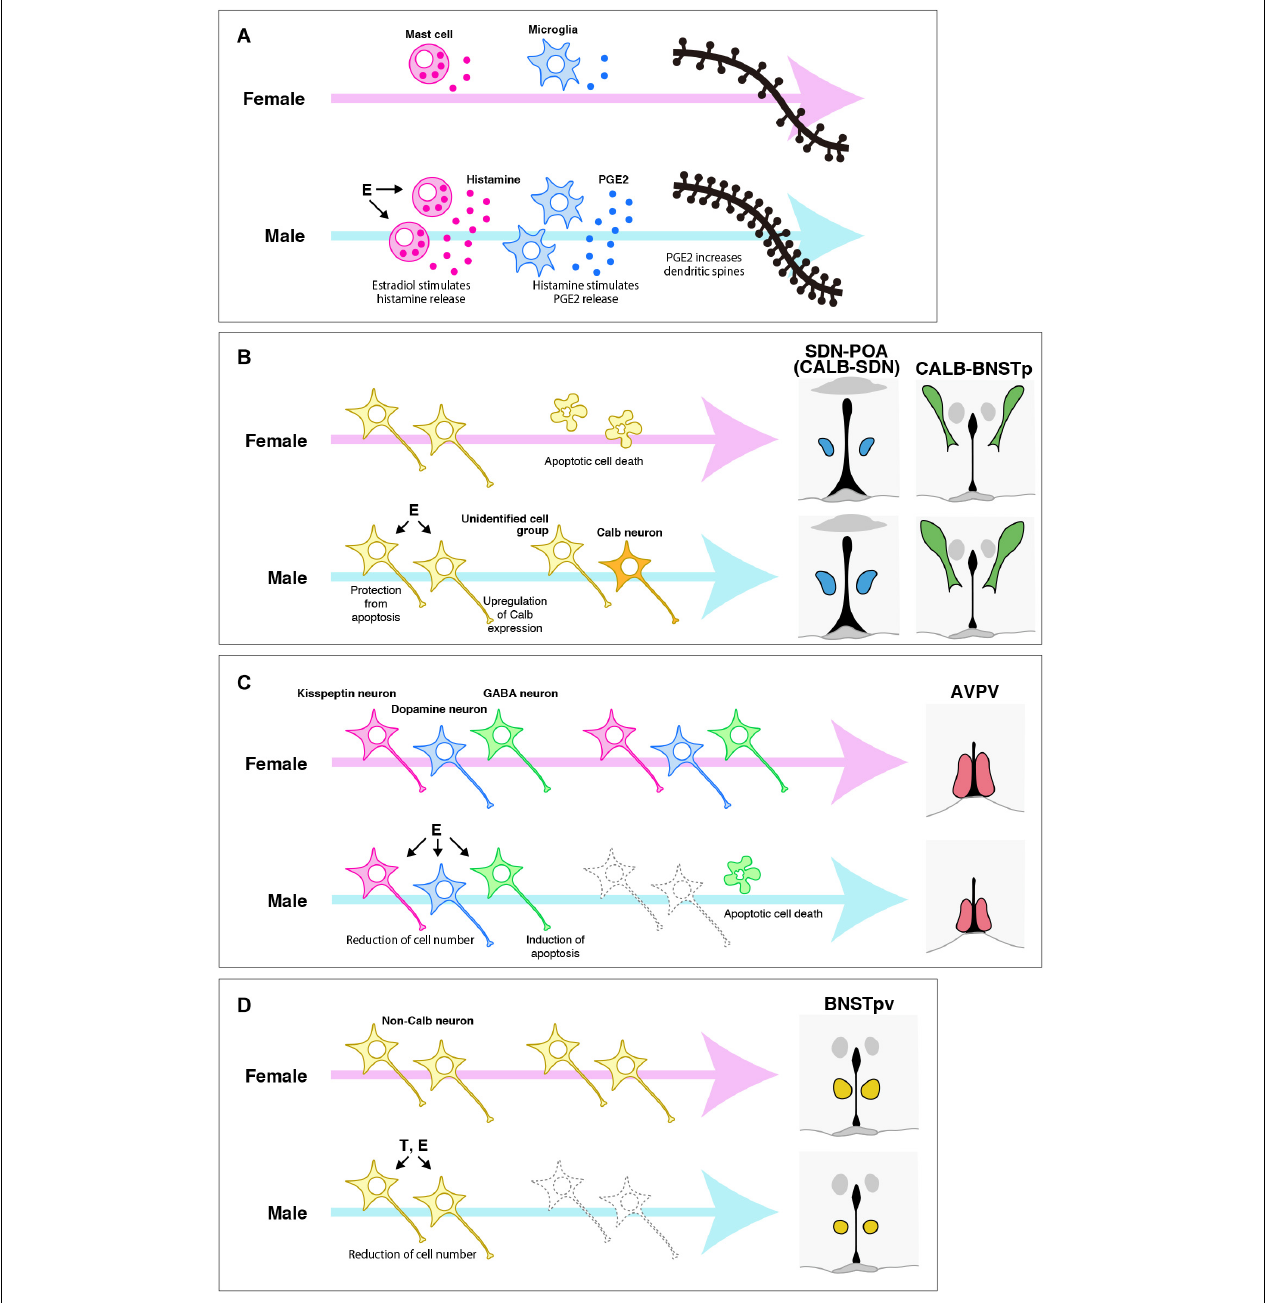
FIGURE 2 | Possible mechanisms for organizing the sexually dimorphic structures of the POA and BNST of rats and mice. (A) The mechanism responsible for the sexual differentiation of dendritic synapse patterning in the POA, which was proposed by McCarthy and colleagues (see reviews Arambula and McCarthy, 2020; McCarthy, 2020). Estradiol (E), which is synthetized in the brain from testicular testosterone (T) during the perinatal period, stimulates histamine release from mast cells, which then stimulates prostaglandin E2 (PGE2) to increase dendritic spines. (B) The mechanism for organizing the sexually dimorphic structures of the SDN-POA/CALB-SDN and CALB-BNSTp. E originating from testicular T in the perinatal period protects a population of neurons from apoptotic cell death, although the neurochemical properties of the cell population have not been identified. Additionally, E may upregulate Calb expression, followed by induction of a male-biased sex difference in the number of Calb neurons. (C) The mechanisms for inducing a female-biased sex difference in the number of cells in the specific neuronal cell groups in the AVPV. E originating from testicular T in the perinatal period induces the death of GABA neurons by apoptosis to reduce their number. E may also reduce the number of kisspeptin neurons and dopamine neurons by a mechanism other than apoptosis, although the mechanism remains unknown. (D) The roles of T and E during the perinatal period in the sexual differentiation of the BNSTpv. T and E reduce the number of BNSTpv neurons that do not express Calb. However, identification of the neurochemical properties and the mechanism responsible for inducing the sex difference require further investigation.